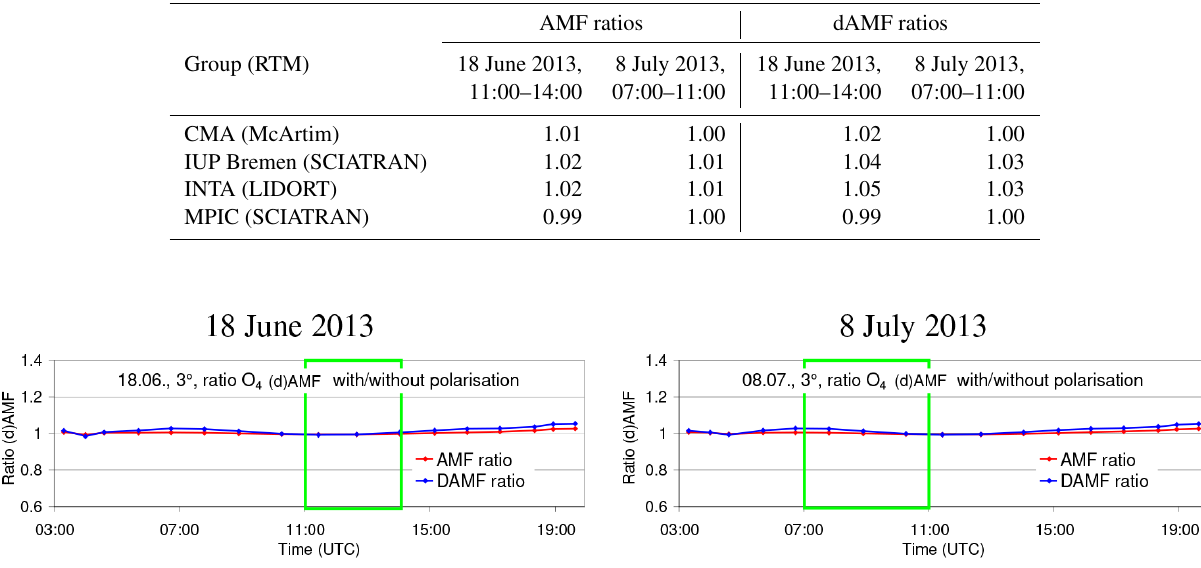
Figure A14. Ratios of the O 4 (d)AMFs considering polarisation vs. those without considering polarisation for both selected days.